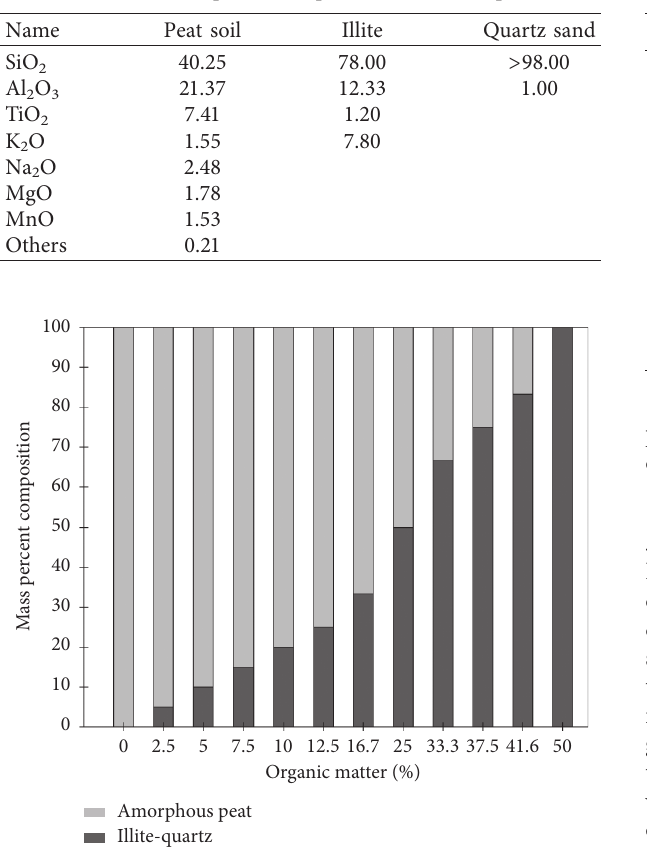
Table 2: Chemical composition of peat soil, illite, and quartz sand.